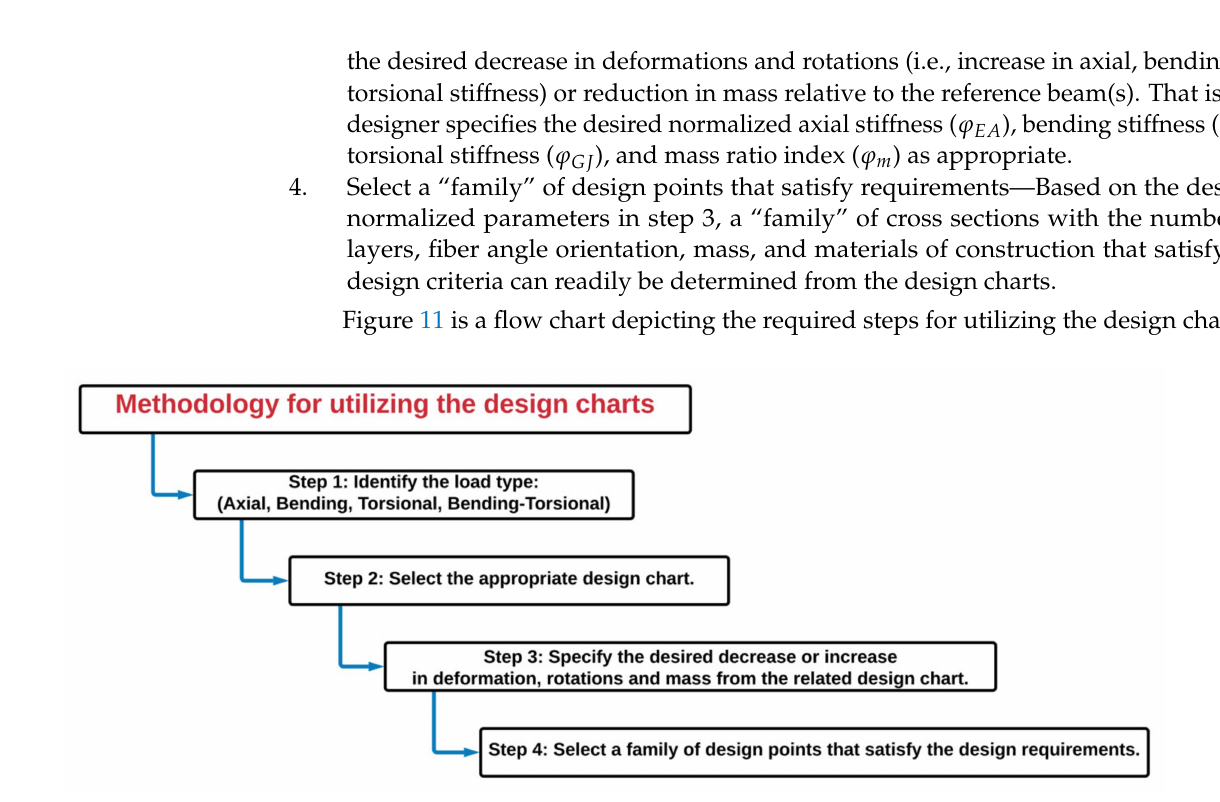
Figure 11. Methodology for utilizing the design